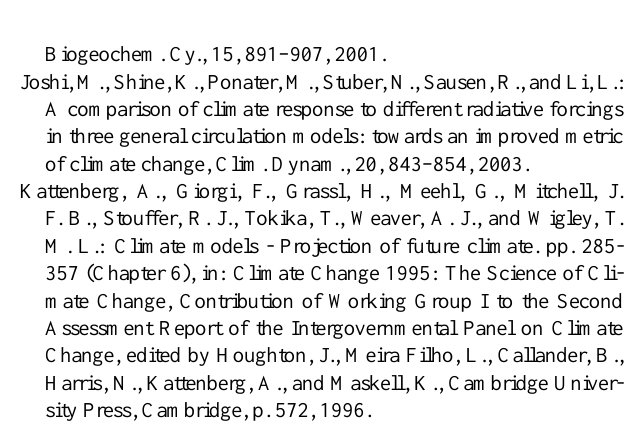
a For a detailed description of the C 4 MIP carbon cycle models, see Friedlingstein et al. (2006) and references therein. For some models data was not available up to 2100 (MPI, IPSAL: up to 2099; FRCGC: up to 2098). In such cases, the latest available model years are provided in the Goodness of fit section. The RMSE is calculated over the last 101 years available. b In the automated calibration procedure, the climate module parameters vert. ocean diffusivity ( K z =2.3cm 2 s − 1 ), and ocean-to-land heat exchange enhancement ( µ =1.4), and land-ocean warming ratio (RLO=1.3) were kept at default values. Climate sensitivity ( 1T 2 × )was calibrated in a first step to match temperatures of the coupled run for the model- specific CO 2 concentrations. c The terrestrial carbon pools of the FRCGC model were not used in the calibration routines as they show significant drift at the start of their coupled and uncoupled